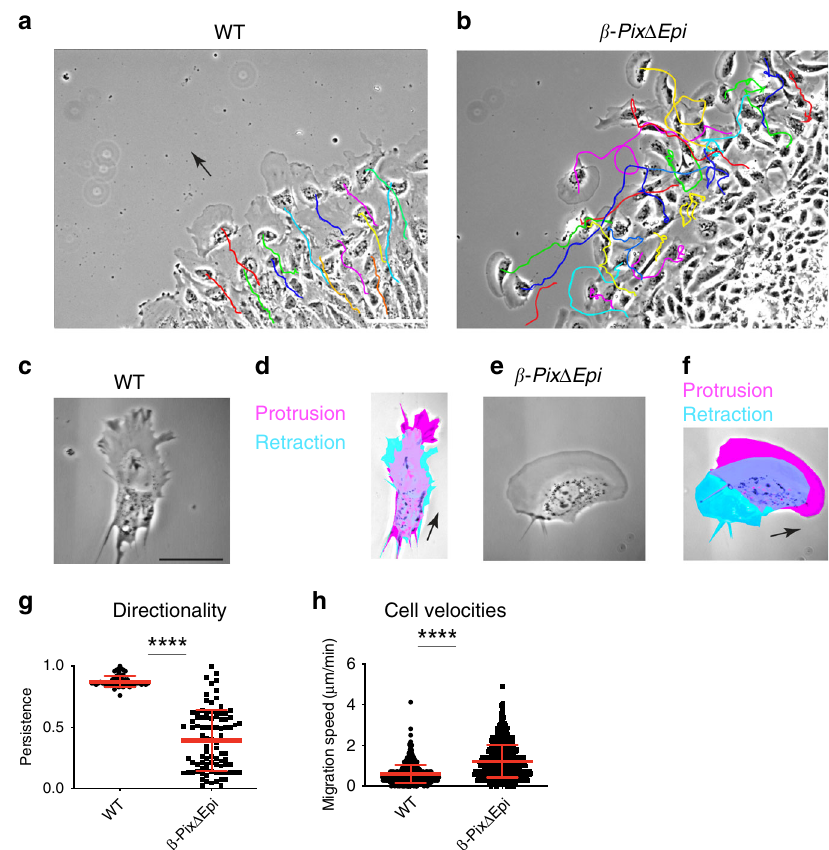
Fig. 3 β -Pix regulates migration in mesoderm explants. a , b Phase contrast time-lapse snapshots with overlaid cell migration trajectories in nascent mesoderm explants imaged for 4 h. Cell tracking shows that migration of wild-type mesoderm explant cells is directional ( a ) and is disrupted in β -Pix Δ mutant cells ( b ). c – f Location of cell protrusions depends on β -Pix. Phase contrast images ( c , e ) with time-lapse overlays ( d , f ) of individual migrating cells on 2D surface. A wild-type mesoderm ( c , d ) cell shows protrusions restricted to the leading edge, in contrast to the β -Pix Δ mutant cell ( e , f ), where the entire leading edge protrudes. g Persistent directional migration is disrupted in β -Pix Δ mutant explant cells (0.87 ± 0.05, n = 61 wild-type cells, 4 embryos; 0.39 ± 0.2, n = 91 mutant cells, 6 embryos); mean ± s.d. **** p < 0.0001 (two-tailed Student ’ s t -test), p = 0.0036 (one-way ANOVA). h The cell velocities are signi fi cantly higher in the absence of β -Pix than in wild-type cells. **** p < 0.0001 (two-tailed Student ’ s t -test), p = 0.0005 (one-way ANOVA) (0.6 ± 0.45 µ m/min, n = 641 wild-type cells; 1.23 ± 0.8 µ m/min, n = 883 mutant cells). Scale bars, 100 µ m ( a , b ), 30 µ m ( c – f